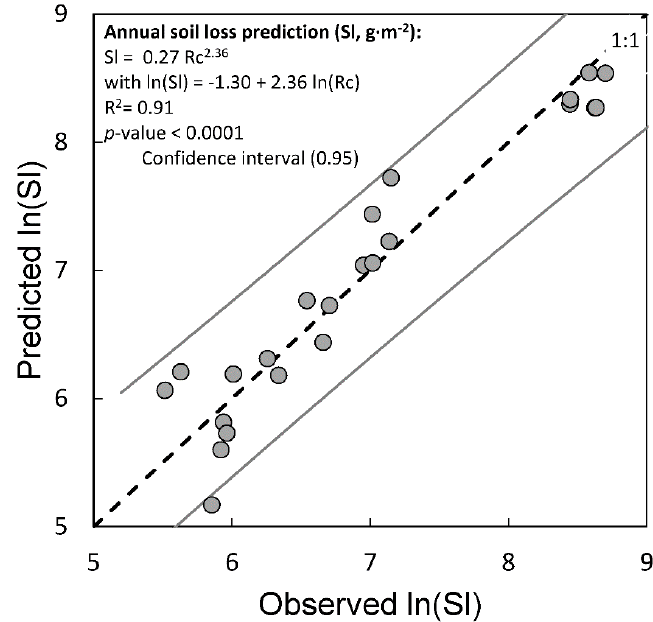
Figure 9. Observed and modelled seasonal soil loss. Each point represents the seasonal soil loss of the 24 microplots. Values (in g·m − 2 ) were predicted using the simple formulation ln(Sl) = − 1.30 + 2.36 ln(Rc), where Rc is the seasonal runoff coefficient and Sl is the seasonal soil loss, as proposed by [31] . Observed Rc and Sl were measured from 4 June to 15 October 2017, in Ban Kokngew, Luang Prabang Province, Lao People’s Democratic Republic.